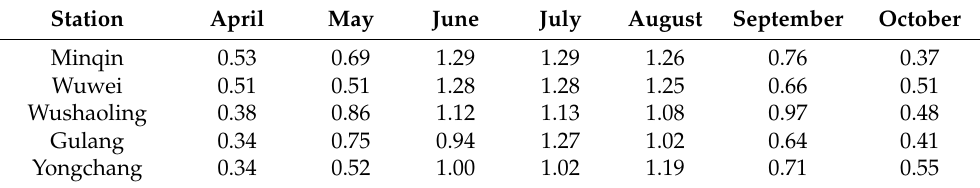
Table 2. K c values for each meteorological station during the growing